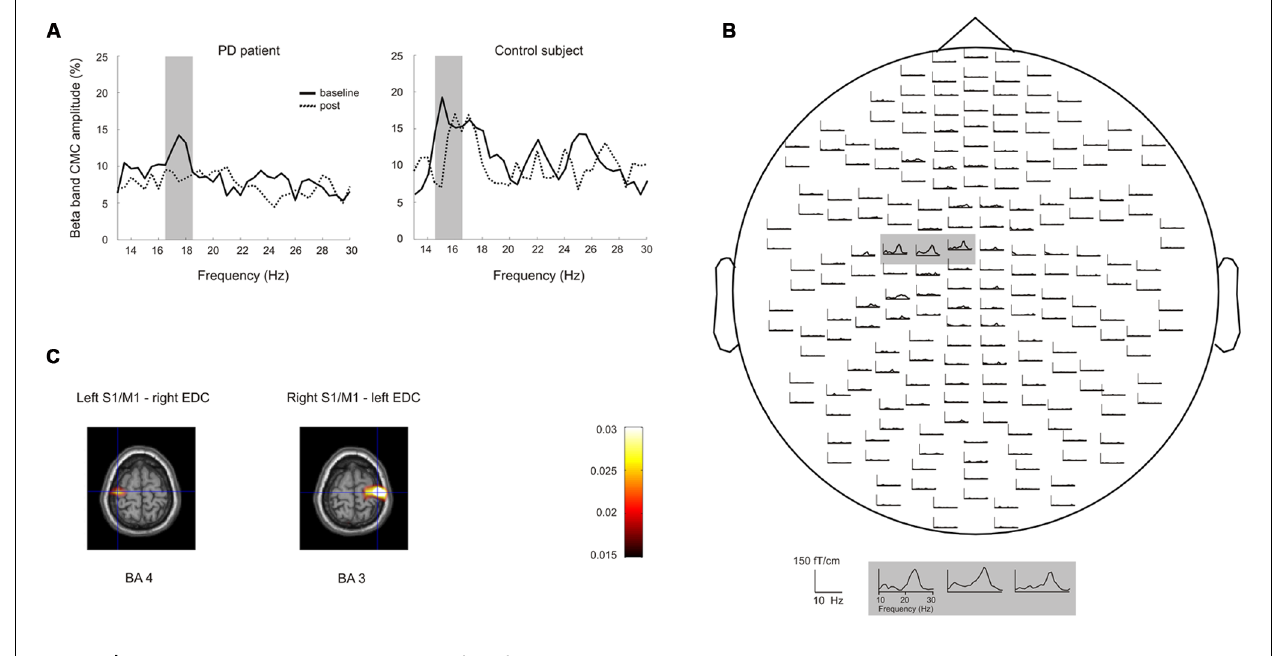
within the frequency range from 10 Hz to 30 Hz. The most prominent beta band CMC peaks are localized in sensors corresponding to the left S1/M1 region. (C) Beta band CMC source localization in Brodmann Area (BA) 3/4 in two representative individual data sets.